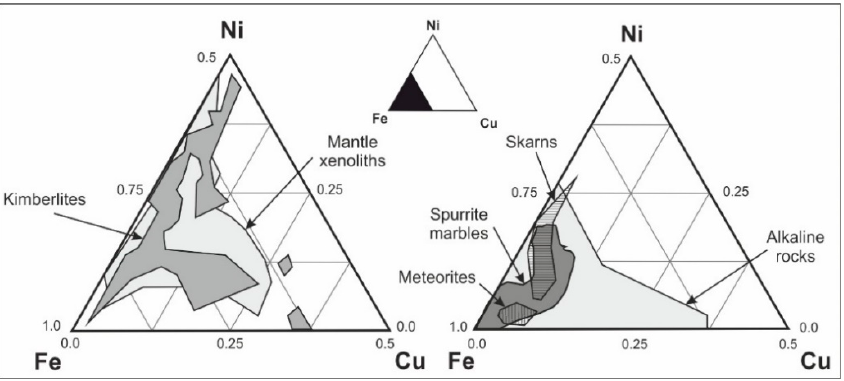
Figure 17. Fe–Ni–Cu diagram (at%) of djerfisherite compositions from the terrestrial rocks of various genesis and meteorites. Modified version after [31]. Based on data: mantle xenoliths [73–80], field of djerfisherite from spurrite marbles plotted using author data.